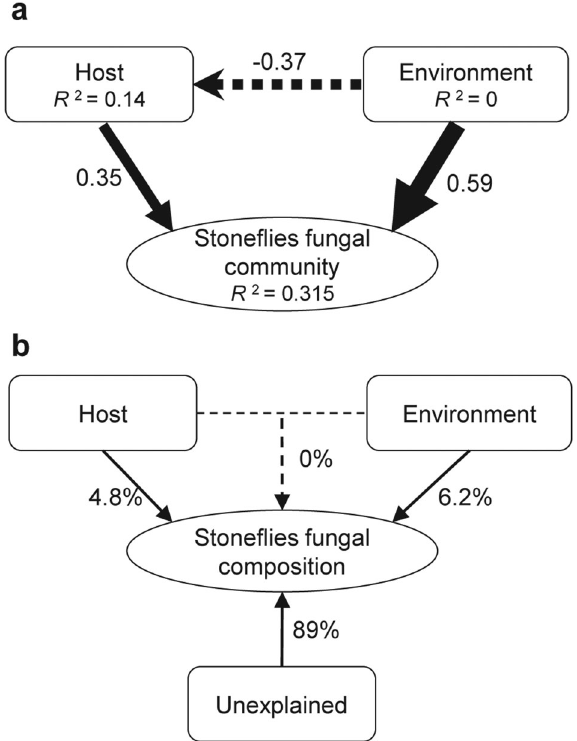
Fig. 4 The effect of host-related and environmental factors on the stone fl y fungal community composition. a Structural equation model provided insight on connections between both host-related and environmental variables to fungal community composition. The blue and red arrows indicate statistically signi fi cant negative and positive paths, respectively. The width of the arrows represents the strengths of these relationships. The R 2 values under each box indicate the amount of variation in that variable explained by the input arrows. Numbers next to arrows are unstandardized slopes. b Variance partitioning analysis